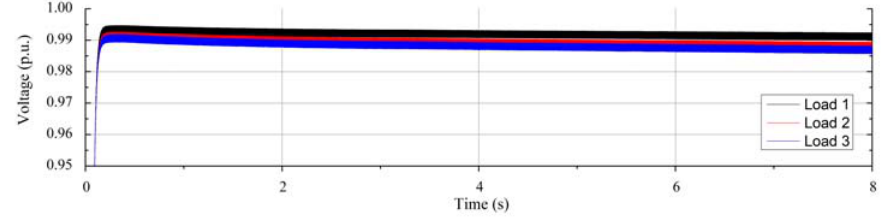
Figure 8. AC side root mean square (RMS) voltage at connection point for loads.